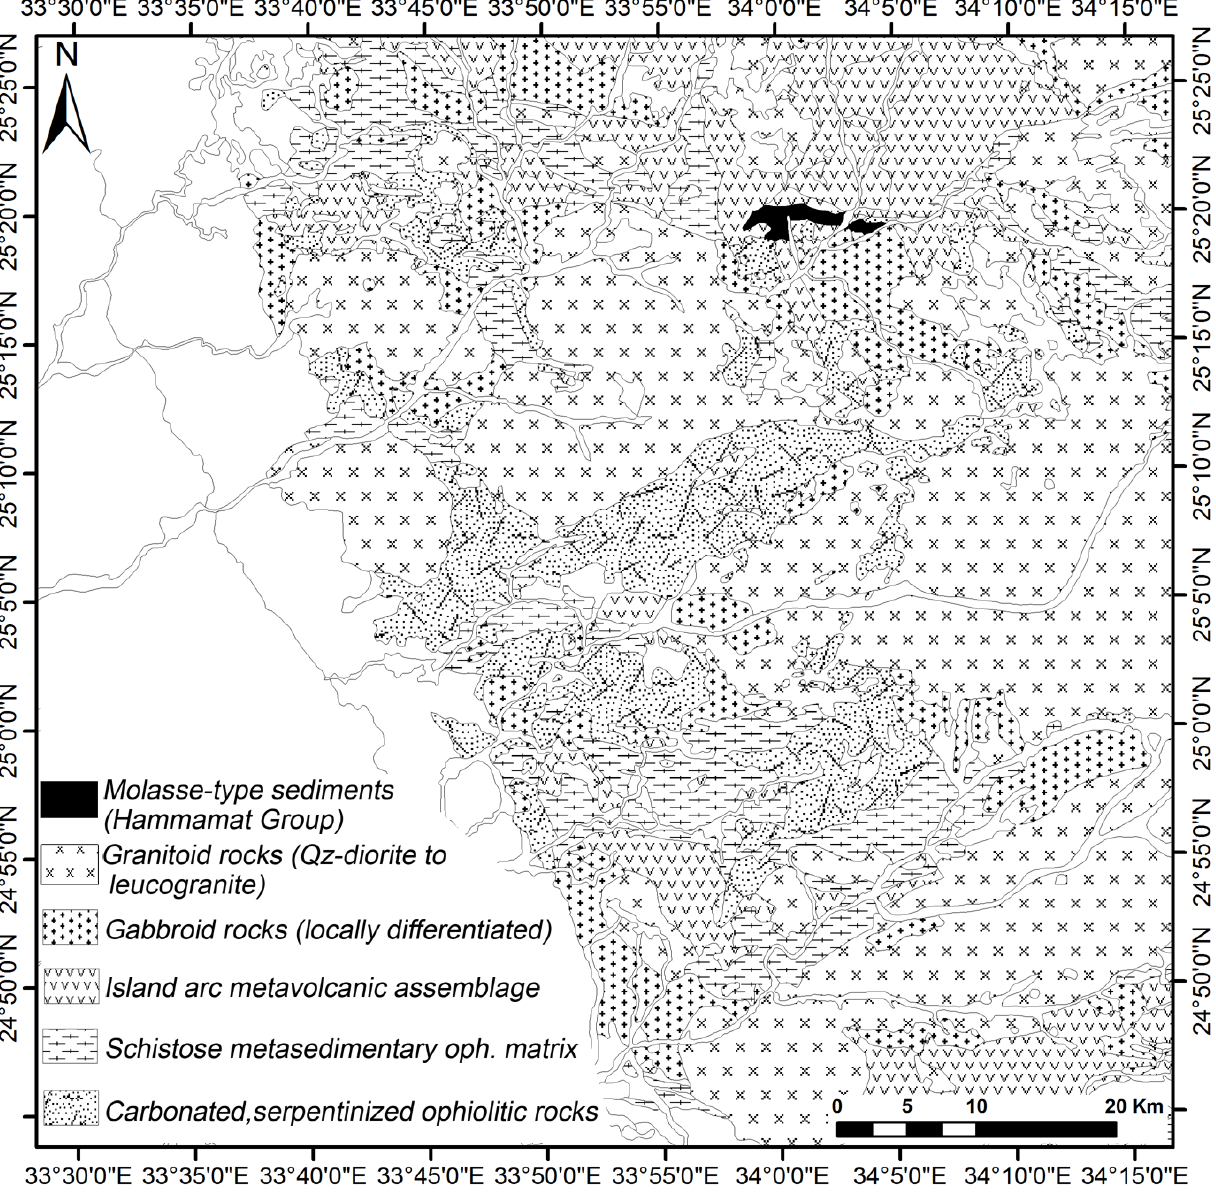
Figure 11. Simplified geological map of Barramiya – Um Salatit district, CED, Egypt. Modified after EGSMA [23] .